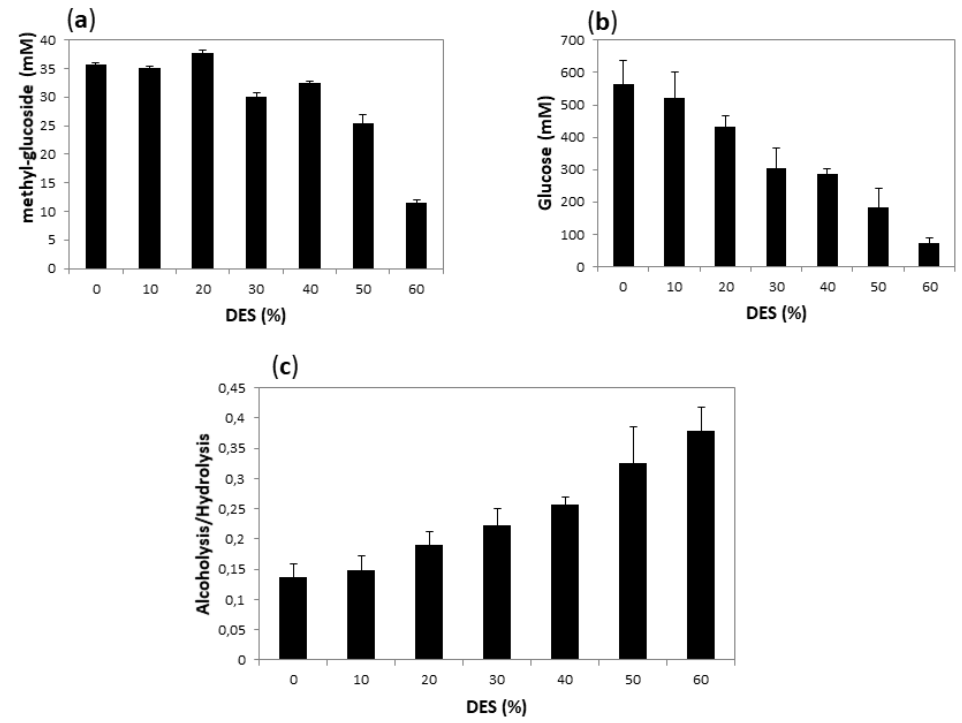
Figure 8. Methanolysis of starch after 18 h using Amy A as a catalyst, and 10% MeOH in different concentrations of choline chloride:urea (1:2):water DES as a solvent. ( a ) shows the yield of alcoholysis reaction (expressed as mM of methyl-glucoside); ( b ) the yield of hydrolysis (expressed as equivalent to dextrose in mM) and ( c ) the alcoholysis / hydrolysis ratio. The values were calculated as described in Materials and Methods.